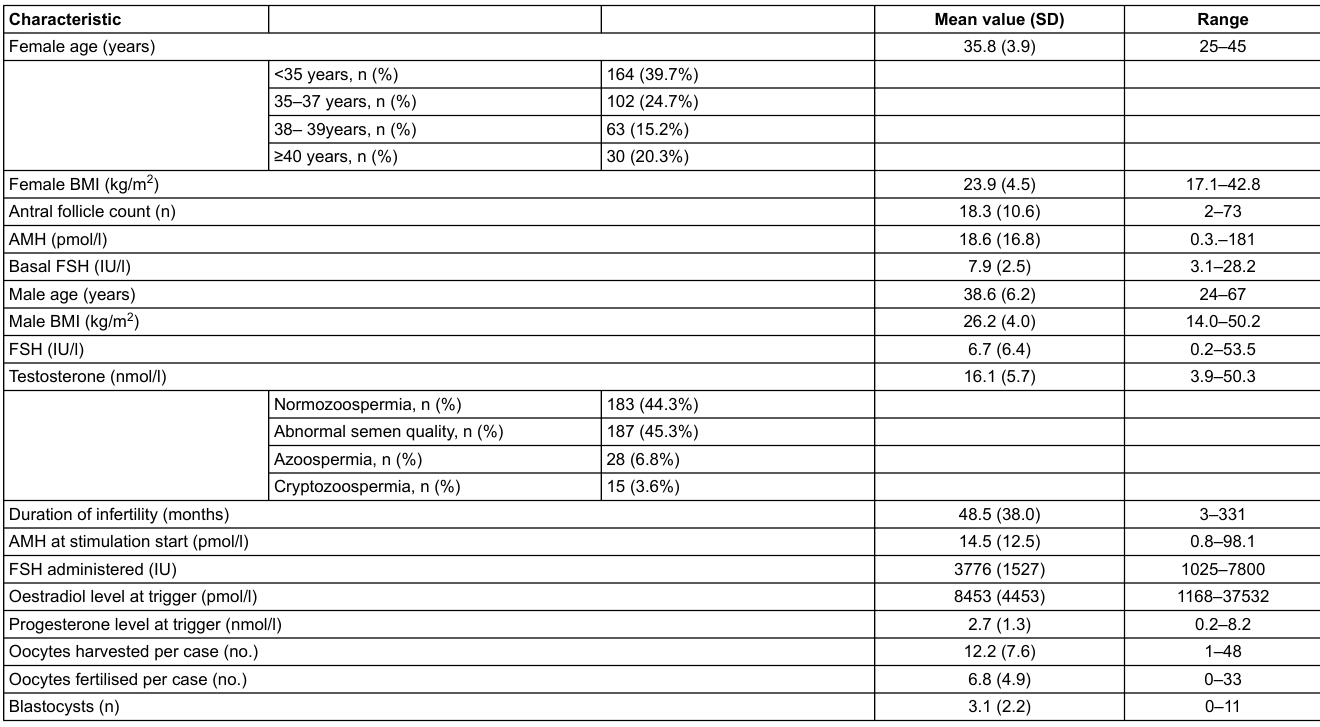
Table 1: Characteristics of the 413 couples during the cycle for oocyte harvest.